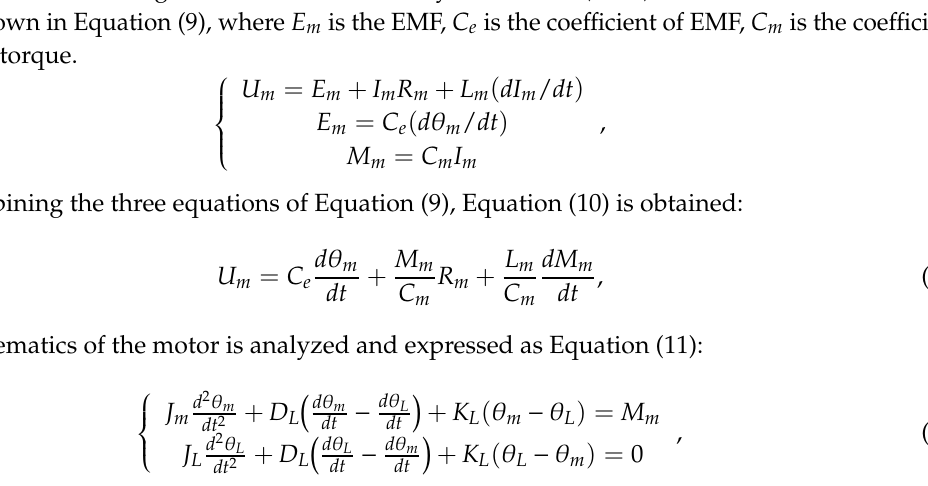
Figure 7. Equivalent armature circuit of the motor.